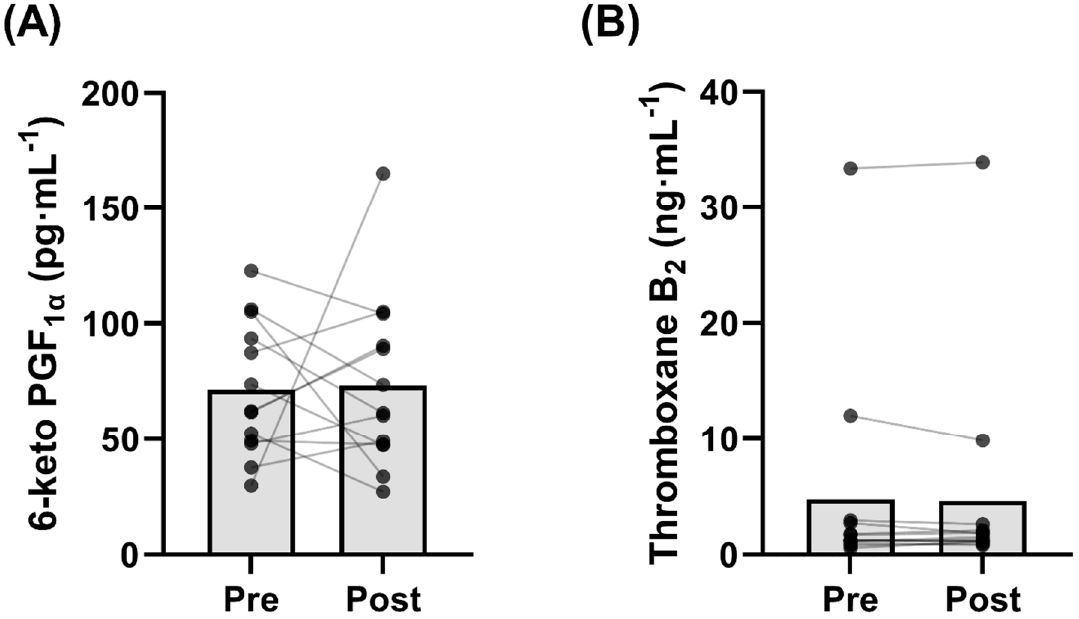
Figure 7. Plasma levels of ( A ) 6-keto prostaglandin F 1 α (6-keto PGF 1 α ) ( p = 0.895) and ( B ) thrombox- ane B 2 ( p = 0.579) measured pre- and post-training ( n = 13).